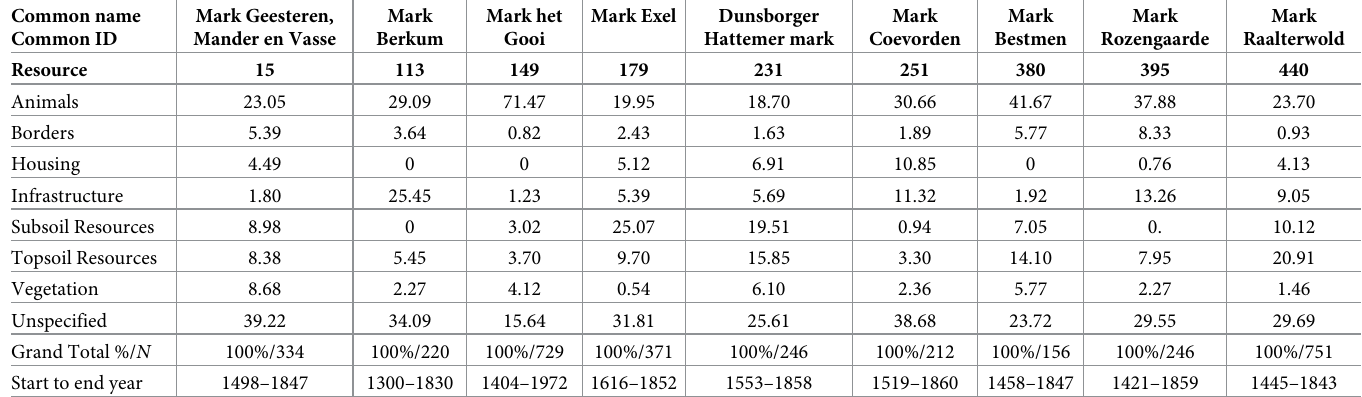
Table 1. Characterization of Dutch commons according to the percentage of total number of regulatory activities (rules) that pertain to eight types of resources. A higher resolution characterization of each type of collective resource is provided in S1 Table. Common name Common